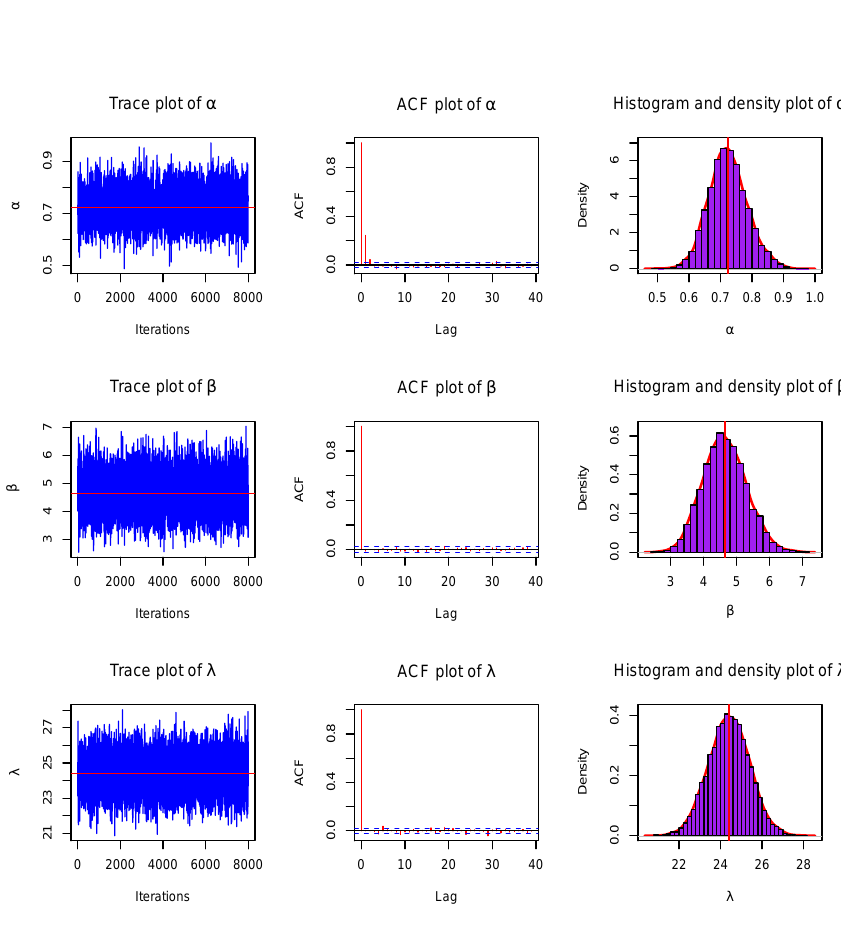
Figure 3 – MCMC dignostic plots of the